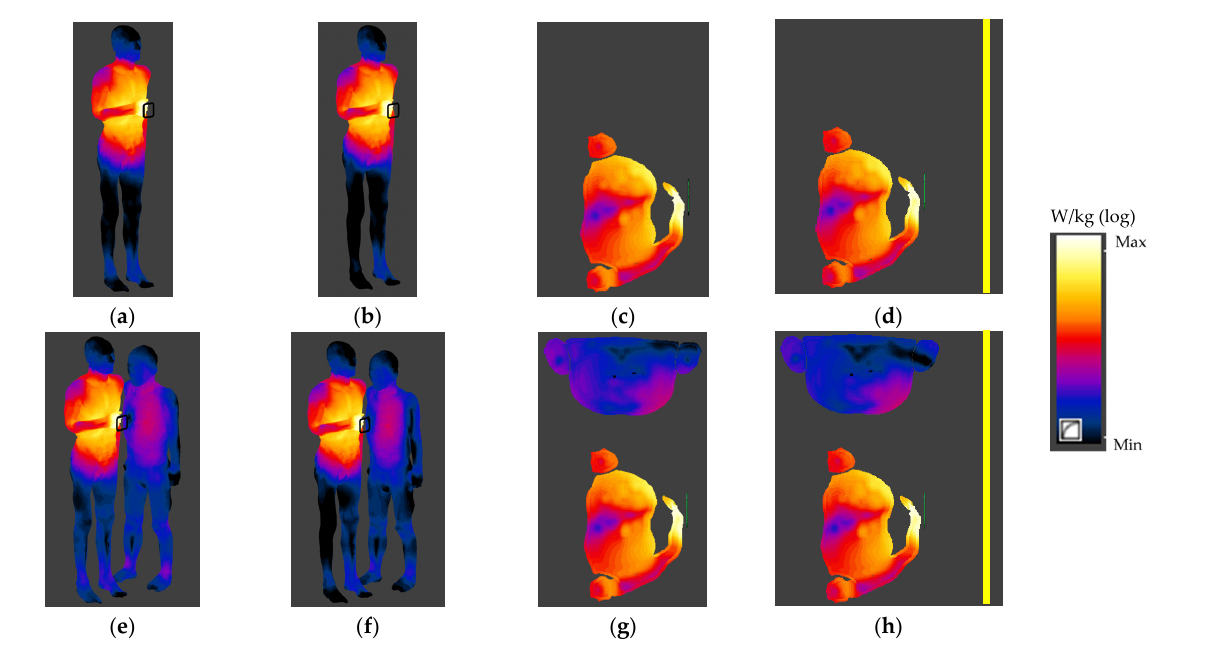
Figure 7. The normalised SAR distribution in the human body exposed to EMF near an HF RFID reader in various exposure scenarios: ( a – d ) a person using a PICC device; ( e – h ), a person using a PICC device and a bystander (side view ( a , b , e , f ) or horizontal cross-section perpendicular to the centre of the reader plane ( c , d , g , h ); reader on a vertical column ( a , c , e , g ) or attached to the vehicle cabin ( b , d , f , h ); logarithmic scale).